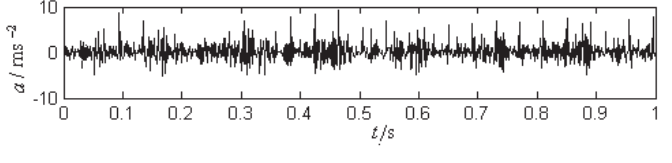
Fig. 2. The vibration acceleration signal of a gear with crack.